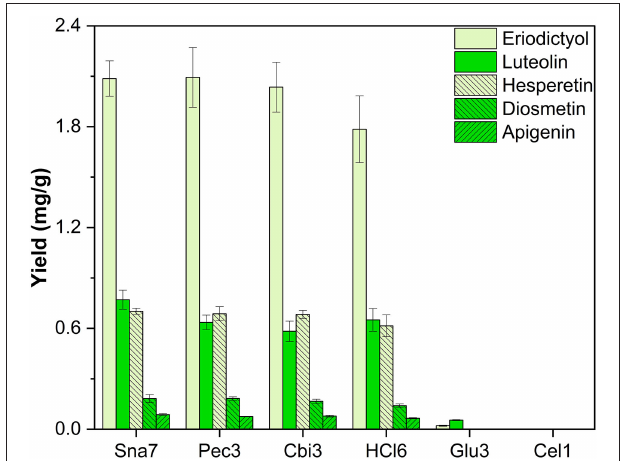
FIGURE 7 | Aglycone yields (mg/g) from leaf extracts of M. × piperita . Enzymatic hydrolysis (25min): Sna7: 5mg snailase (pH 5.5, 37 ◦ C); Pec3: 20U pectinase (pH 4.5, 40 ◦ C); Cbi3: 5U cellobiase (pH 4.5, 37 ◦ C); Glu3: 20U β -glucosidase (pH 5.5, 37 ◦ C); Cel1: 20U cellulase (pH 5.5, 52 ◦ C). Acidic